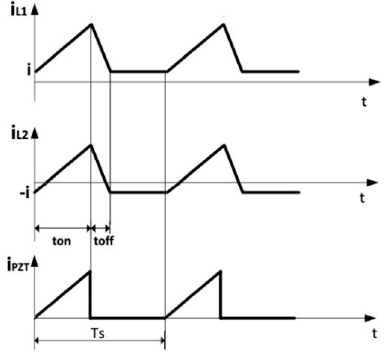
Figure 7. Inductors and input